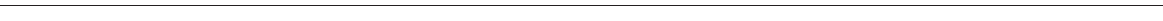
FIGURE 7 | filament densities (filaments/ µ m 2 ): 0.03, 0.17, 0.34 and the following dimensionless area fractions: 0.004, 0.02, 0.04. For each concentration pair observed, we used the definitions of isotropic, nematic, and polar described in Figures 4 , 5 to describe the organization of actin filaments or microtubules. Isotropic organizations are denoted with a filled circle. Polar organizations are denoted with a single-headed arrow. Nematic organizations are denoted with a double headed arrow. Some organizational states were difficult to determine or showed different organizations in different chambers. These were mixed between isotropic and nematic and are denoted with a double headed wide arrow. For each location on the state diagram, 2–5 different chambers were made and 4–9 different 2–5min movies were recorded over 1h, as described. (B) Example alignment of actin and microtubules. (i) Images from a timeseries of actin gliding at 10 µ M in the presence of (ii) 5 µ M microtubules. (iii) Images are overlaid with actin in red and microtubules in cyan. Short actin filaments that glide along microtubule bundles are highlighted with an arrow head. Microtubule channel can be seen through the actin channel due to high signal and imperfect dichroic glass. Time between frames in seconds is given under the images, approximately 3s apart. Scale bar is 10 µ